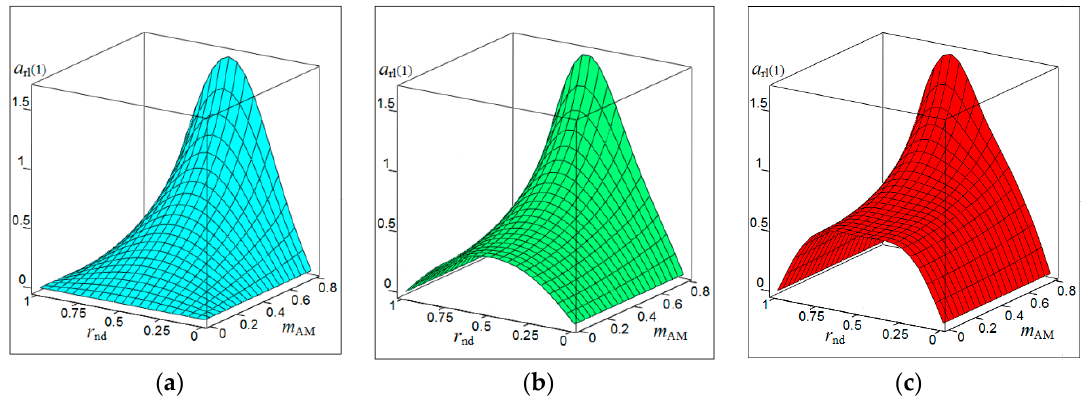
Figure 1. Characteristics of the amplitude selection (CAS) variation of the oscillation amplitude with AFM on the zero harmonic of the modulation frequency calculated for different values of